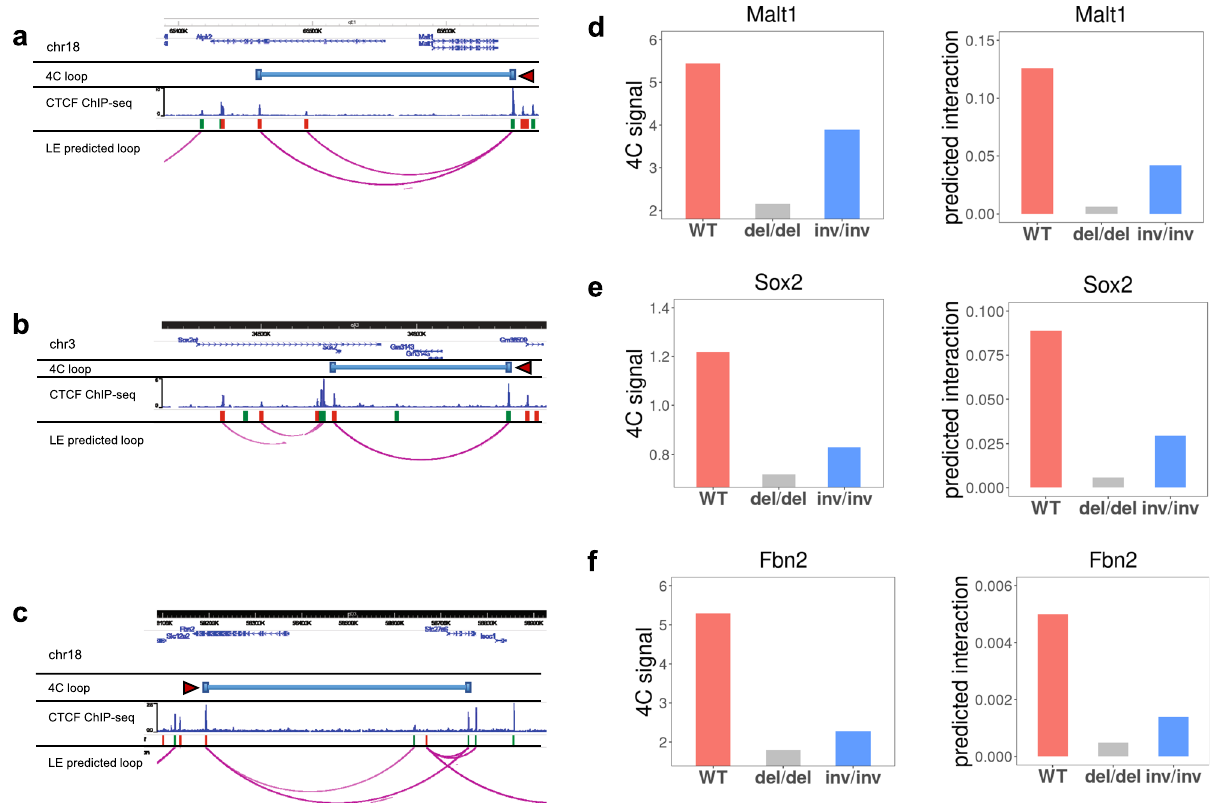
Fig. 7 Loop extrusion model predicts the effect of targeted CTCF disruption and inversion on chromatin interactions. a – c Comparison of contact pro fi les of 4C-seq measurements and our loop extrusion model at the Malt1, Sox2, and Fbn2 loci. Only the strongest loop of the targeted CTCF-binding site (indicated by dark red triangle) from 4C-seq is shown. The orientations of fl anking CTCF motifs are indicated by red (forward) and green (reverse) bars. Our loop extrusion model predicted interacting CTCF pairs are shown, with darker color corresponding to higher interaction probability. d – f 4C-measured interaction frequency and loop extrusion model predicted probability of looping for wild-type and after CRISPR deletion or inversion of the targeted CTCF- binding